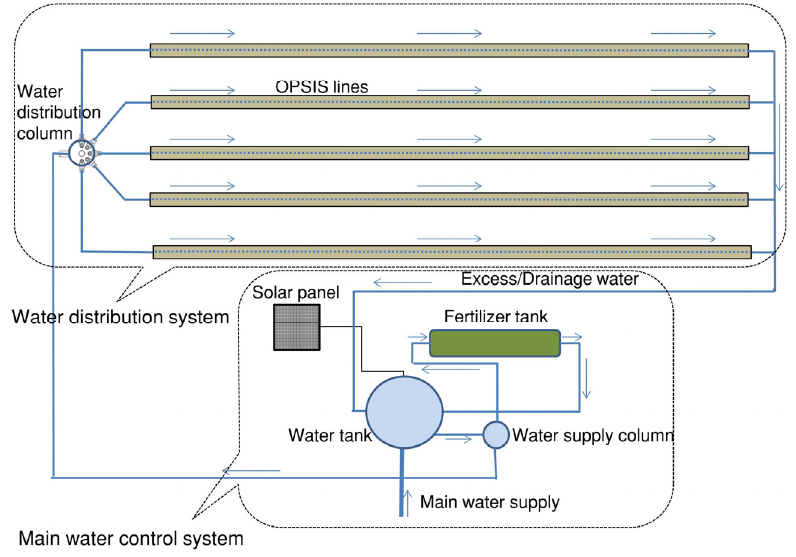
Figure 1. Schematic diagram of Optimized subsurface irrigation system (OPSIS).